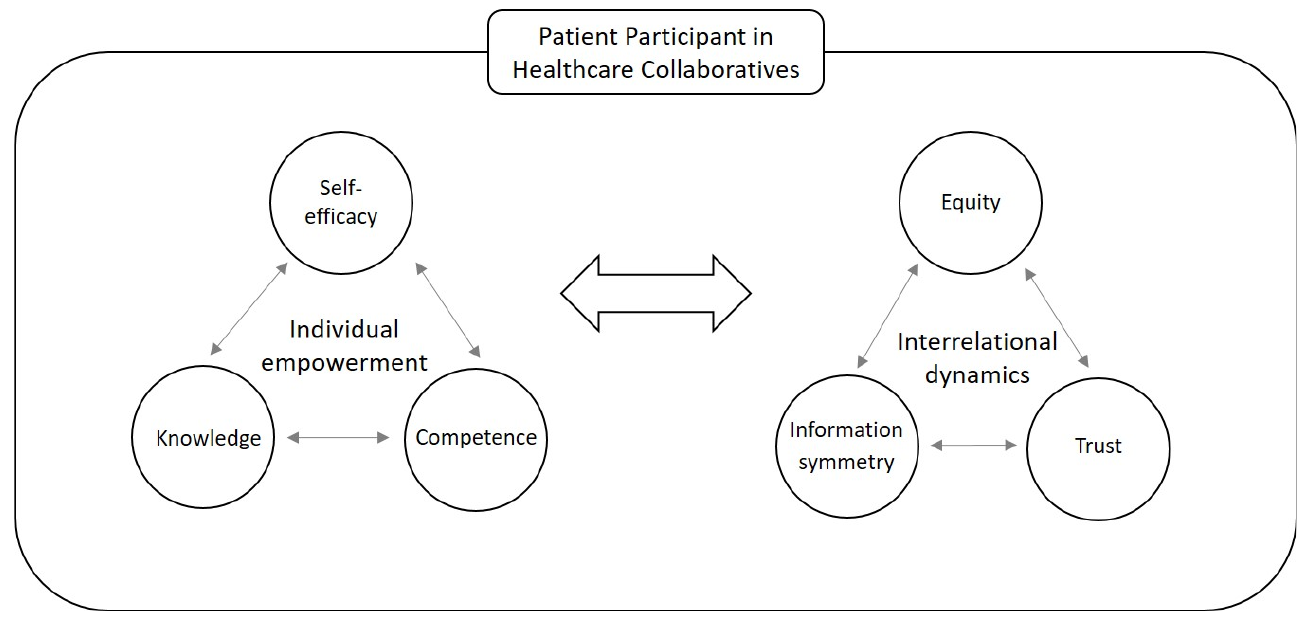
Figure 1. Conceptual model for the process of empowerment (source: own work, based on [30]).